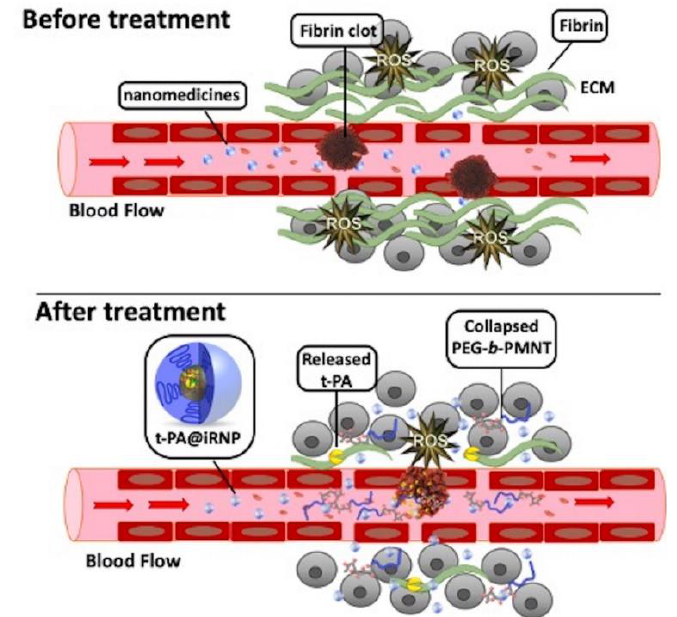
Figure 3. Schematic representation of transmission and action in the microenvironment of large amounts of fibrin around colon tumors and their tissues. Compared with free tissue plasminogen activator (t-PA), using t-PA-assembled redox-active nanoparticles (T-PA@iRNP) can effectively relieve the compressed tumor vessels and upregulate blood perfusion, and improve the poor distribution of nanodrugs in tumors. Reproduced from Mei [134] .